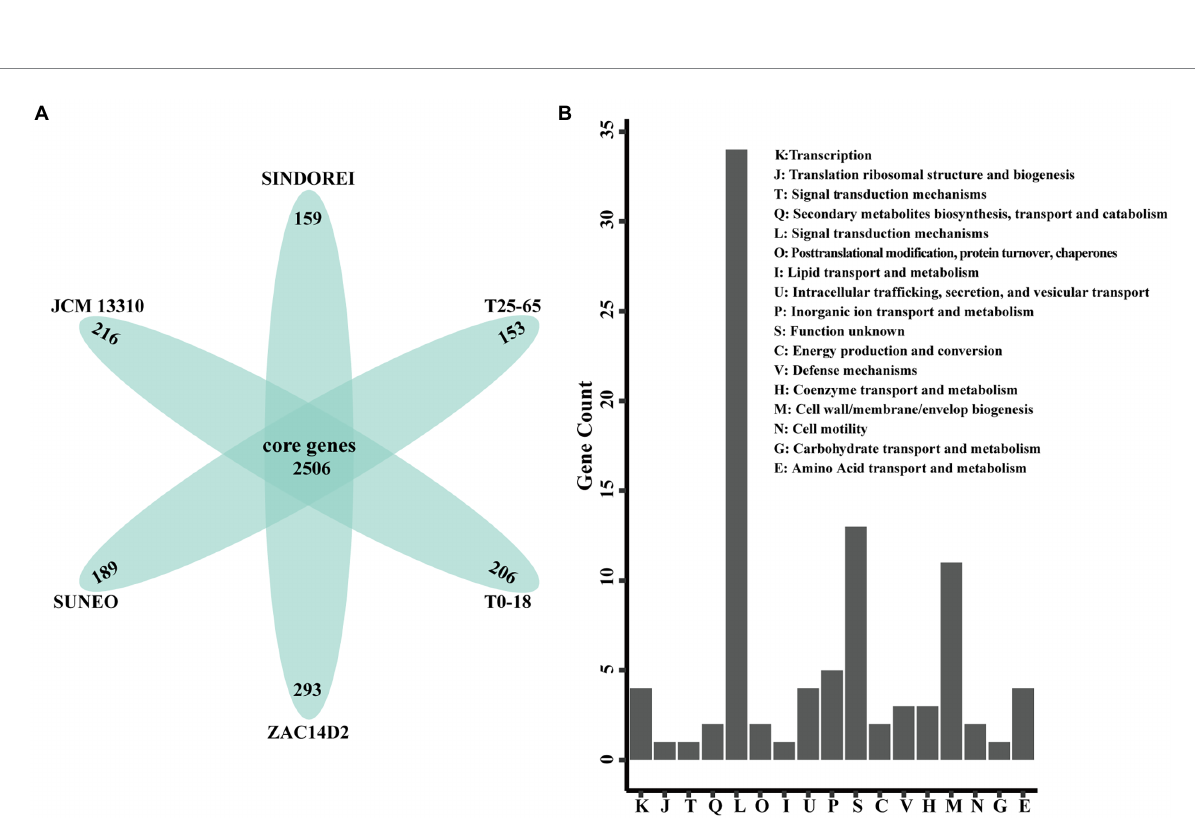
FIGURE 5 Comparison of the gene contents in Stenotrophomonas acidaminiphila . (A) Flower plot diagram showing the core genes and specific genes. (B) Distribution of COG functional annotations of SINDOREI specific